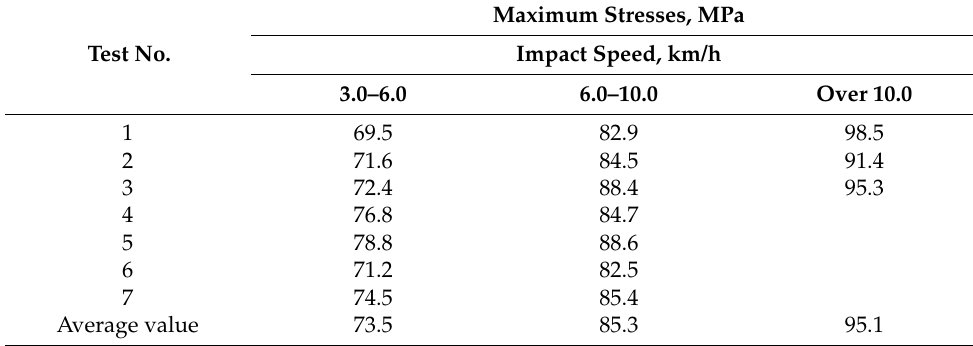
Table 1. The maximum stresses of the flatcar. Test No.